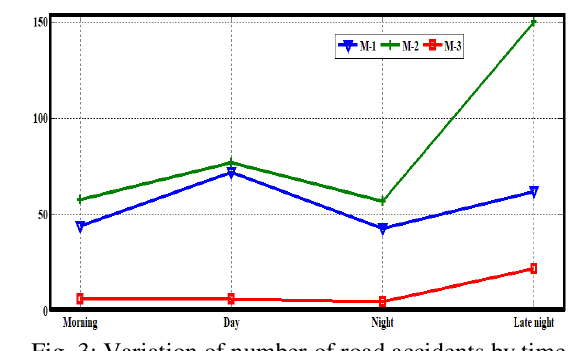
Fig. 3: Variation of number of road accidents by time of the day (M1, M2, and M3) (Morning=06:00-12:00, Day=12:00-18:00, Night=18:00-00:00,